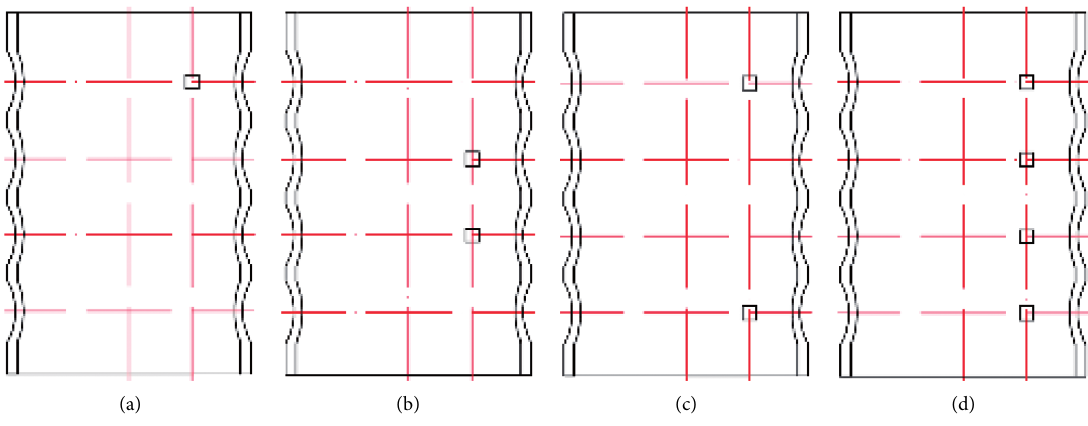
Figure 3: Structure diagram of single-column eccentric initiation